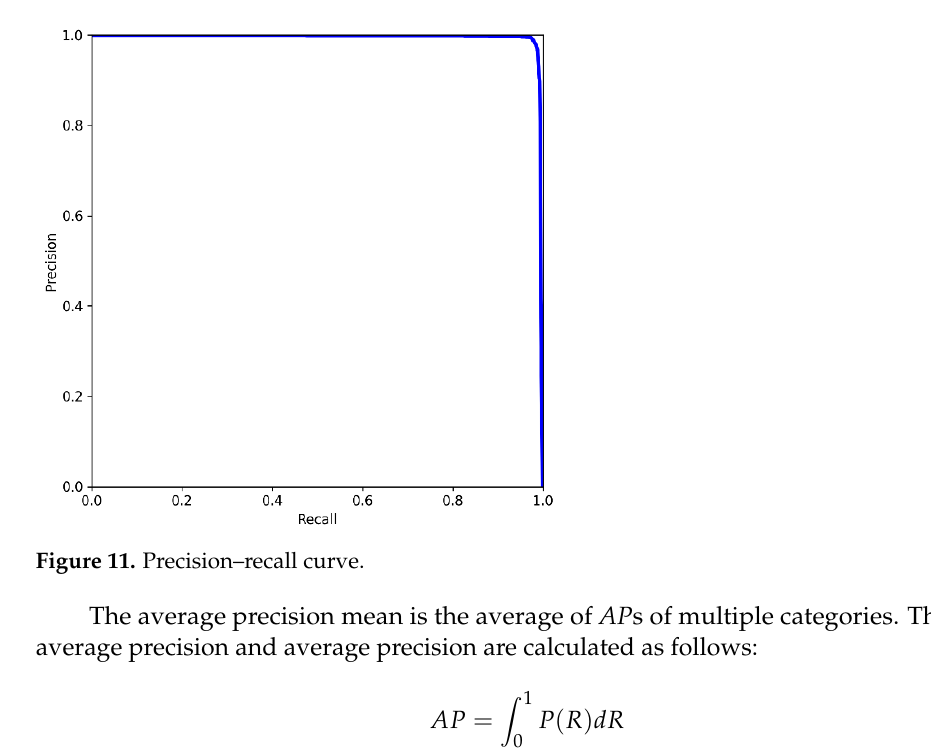
Figure 11. Precision–recall curve.